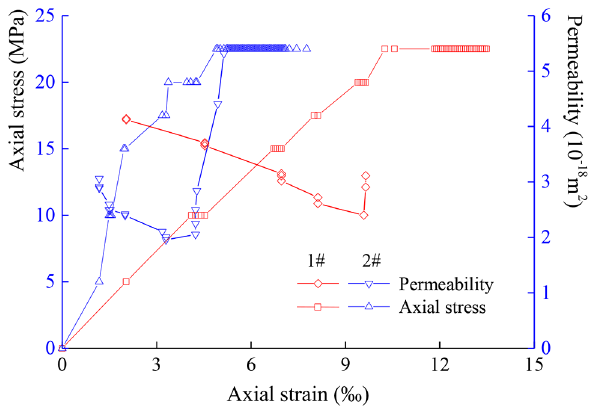
Fig. 5 Relation between permeability evolutions and